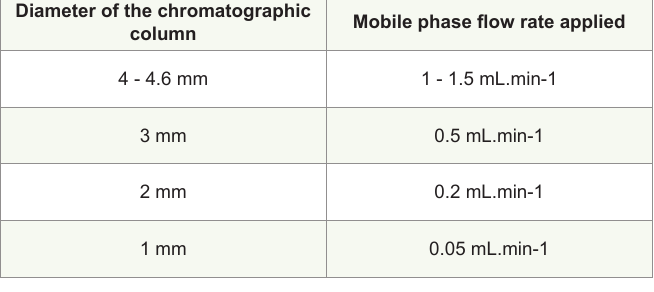
Table 2 : Mobile phase flow rates applied as a function of chromatographic column